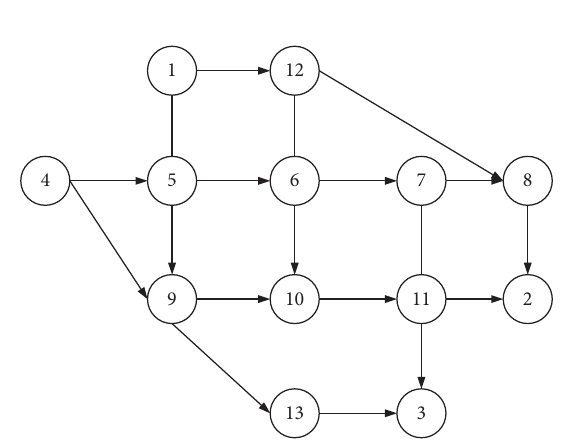
Figure 2: Nguyen–Dupuis’ network. Table 2: Analysis results for Nguyen–Dupuis’ network.